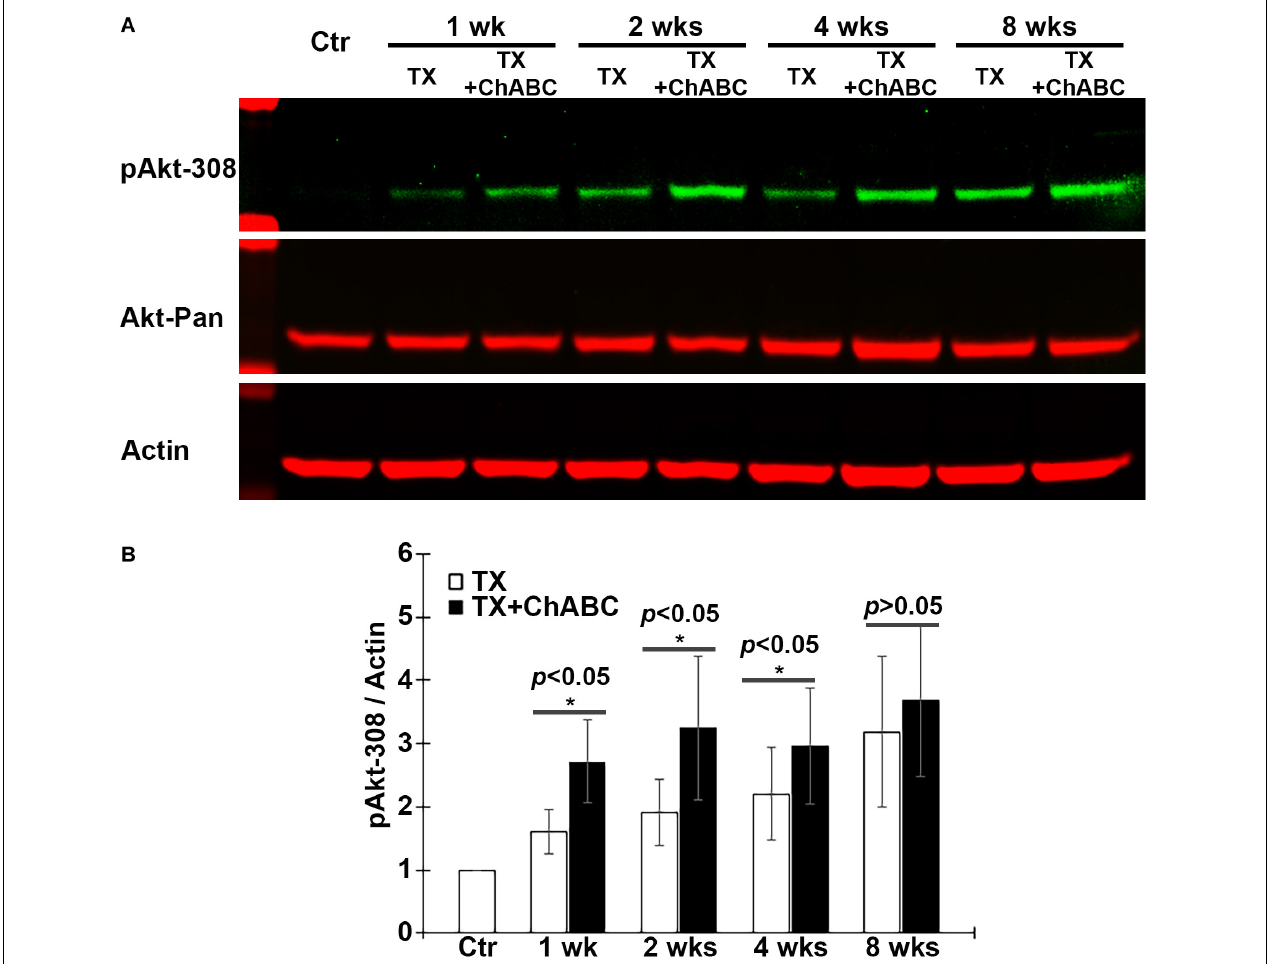
FIGURE 6 | ChABC increases Akt phosphorylation at Threonine 308 (T308) in brain post-TX. (A) Brain homogenates from control lampreys and at 1, 2, 4, and 8 weeks post-TX, treated with ChABC or control enzyme buffer, were examined by western blots and probed with mAbs against pAkt-308, total Akt (Akt-pan) and actin as a loading control. (B) At each time point, ChABC treatment produced a significant increase in pAkt-308 compared with control enzyme buffer (* p < 0.05, n = 5 lampreys per group). Error bars: